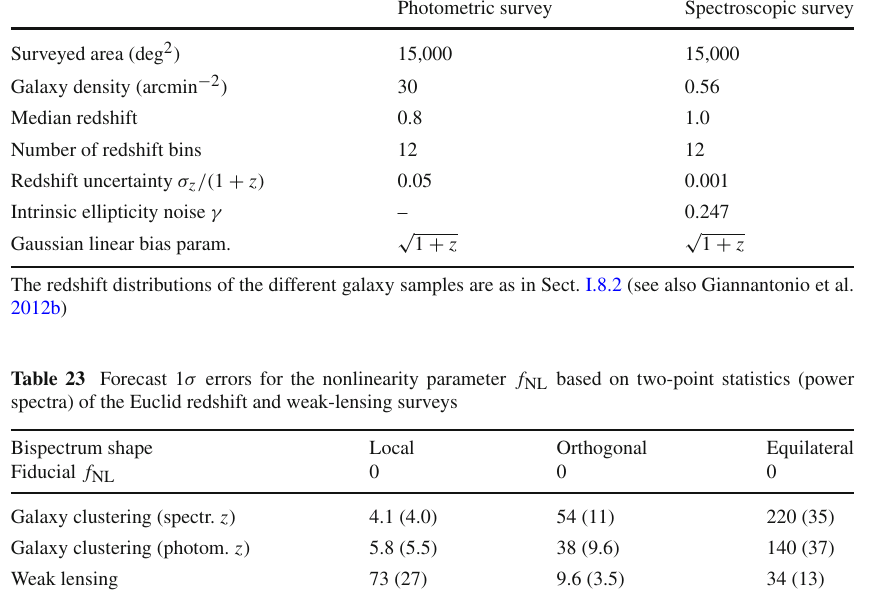
Table 22 Specifications of the surveys used in the Euclid forecasts given in Table 23 Photometric survey